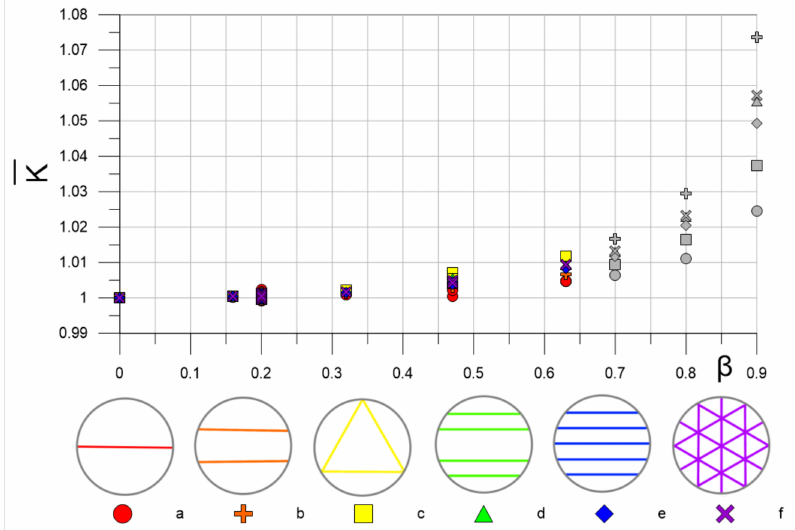
Figure 10. The resulting effect of flow pulsations on the averaged calibration constant for different acoustic path types. Gray markers are predictable